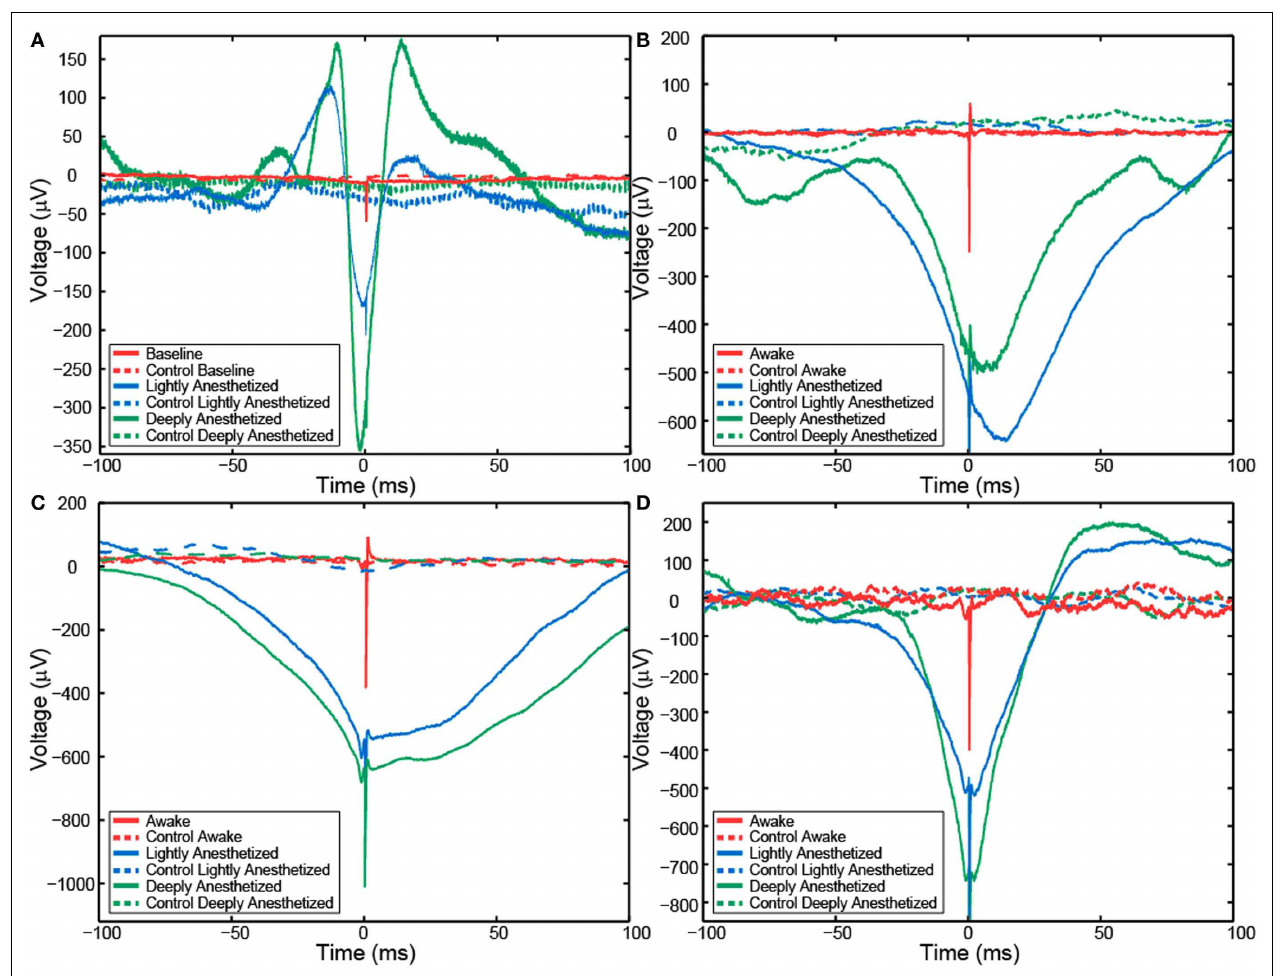
anesthesia increased, the amplitude of the spike-like LFP increased. Dashed lines represent the control cases in which randomly generate AP times were used to align the LFP. Red represents the awake state. Blue represents the lightly anesthetized state. Green represents the deeply anesthetized state.